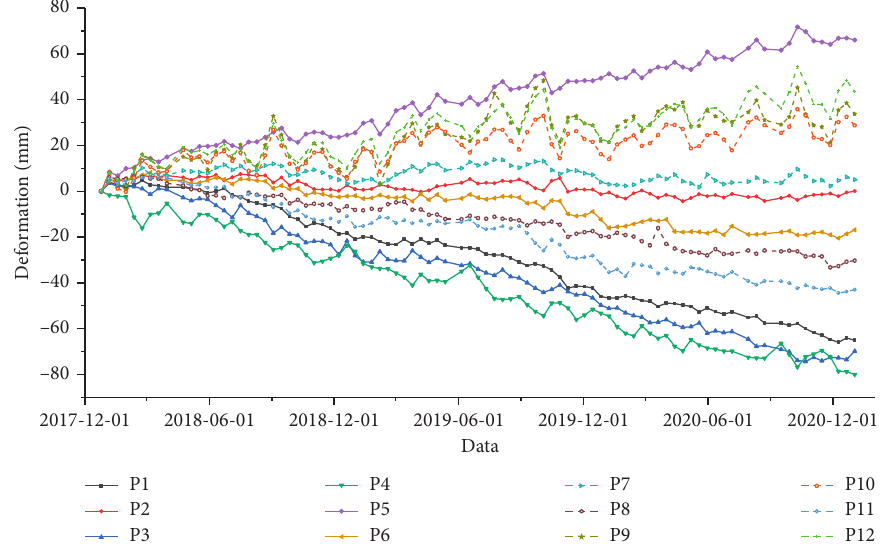
Figure 11: Deformation of the observation